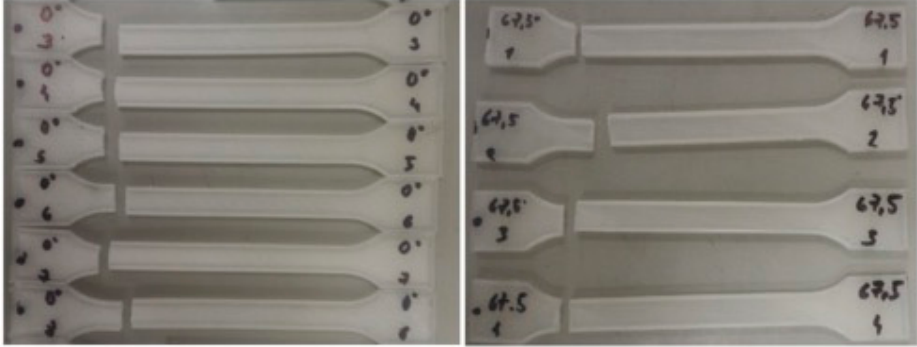
Figure 10. Test results are affected by the default starting point of the printing process.